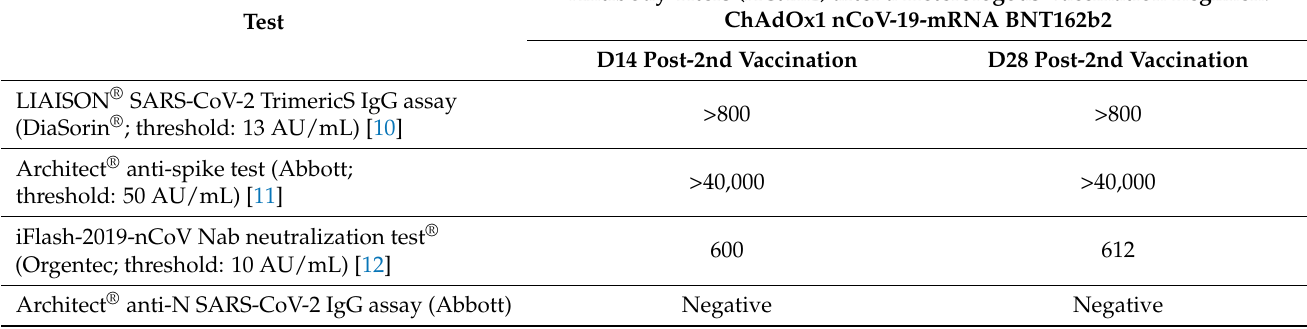
Table 1. Humoral response in a patient treated with teriflunomide and vaccinated with a heterologous protocol (ChAdOx1 nCoV-19-mRNA BNT162b2). Antibody Titers (AU/mL) after a Heterologous Vaccination Regimen: Test